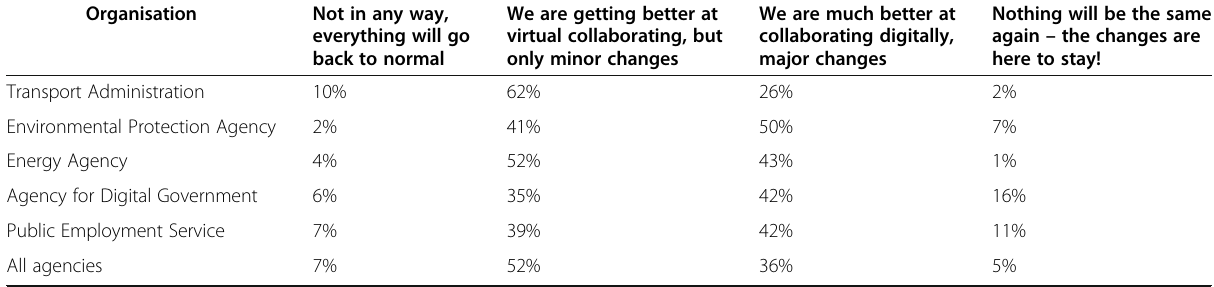
Table 11 Responses to ‘ How Do You Think the COVID-19 Pandemic Will Affect the Ways You and Your Colleagues Interact After the Pandemic is Over? ’